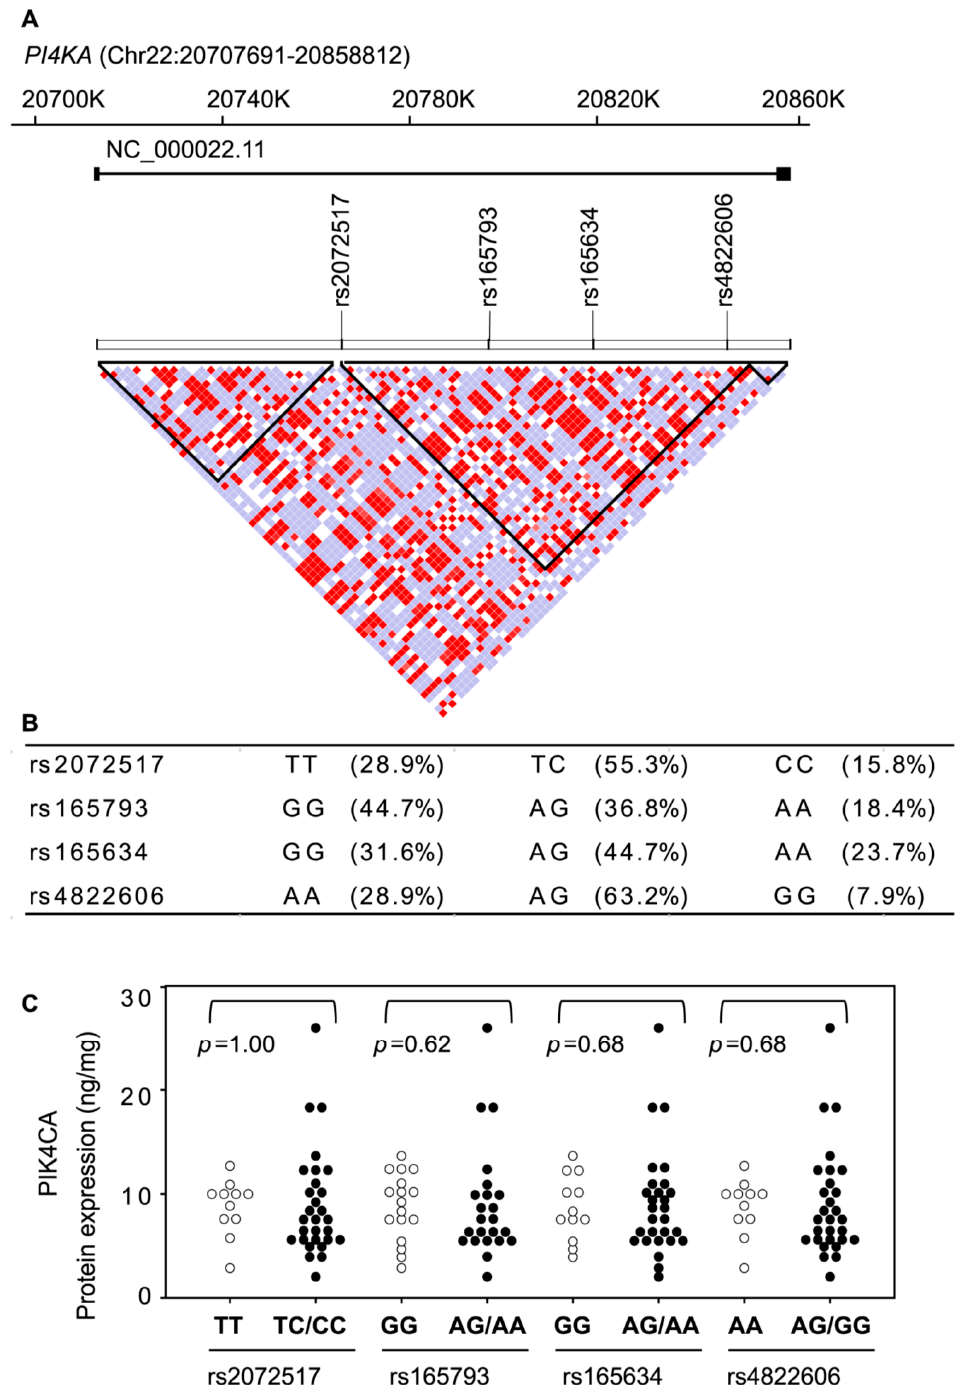
Figure 7. ( A ) . Linkage disequilibrium map of PI4KA locus, the gene encoding PIK4CA protein showing the four SNPs (rs165634, rs165793, rs2072517, and rs4822606) analyzed in this study. For linkage disequilibrium analysis, we used the Japanese healthy controls in the database of the 1000 Genomes Project. Haploblocks were drawn using Haploview v.4.2 software with standard color scheme. ( B ). The allele frequencies of each SNPs of PI4KA . ( C ). The effect of SNPs variants of PI4KA on the protein expression of PIK4CA. The expression levels of proteins were compared between groups using the Mann–Whitney U -test.